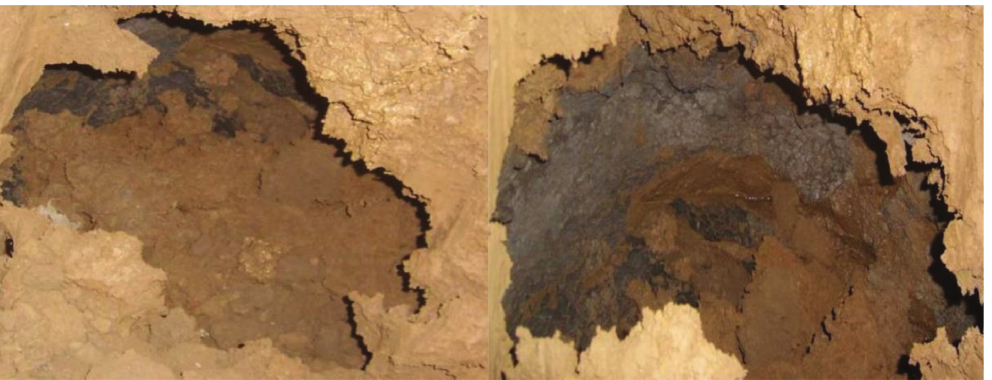
Figure 7: Explosive cavity in the soil. Table 8: Result of the explosion cavity